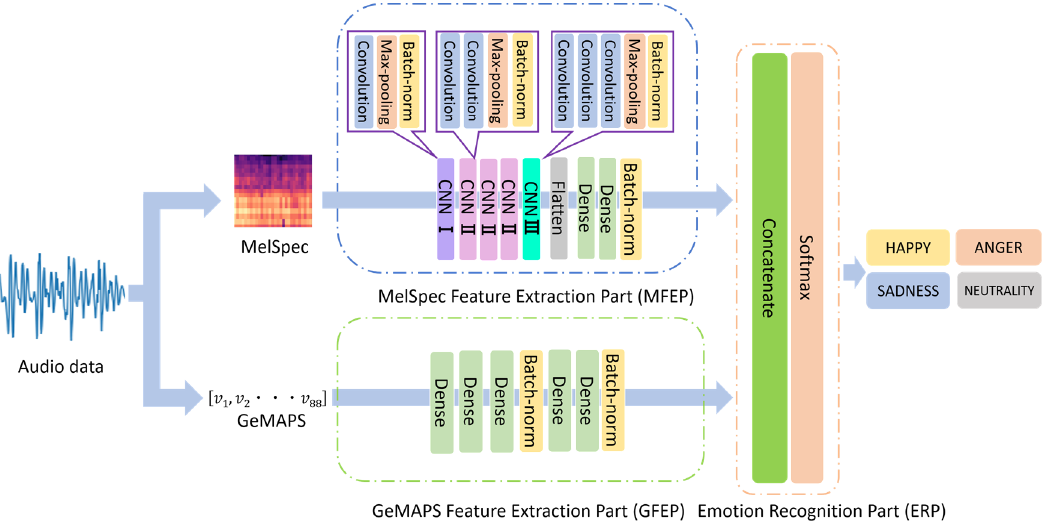
Figure 1. Architecture of proposed